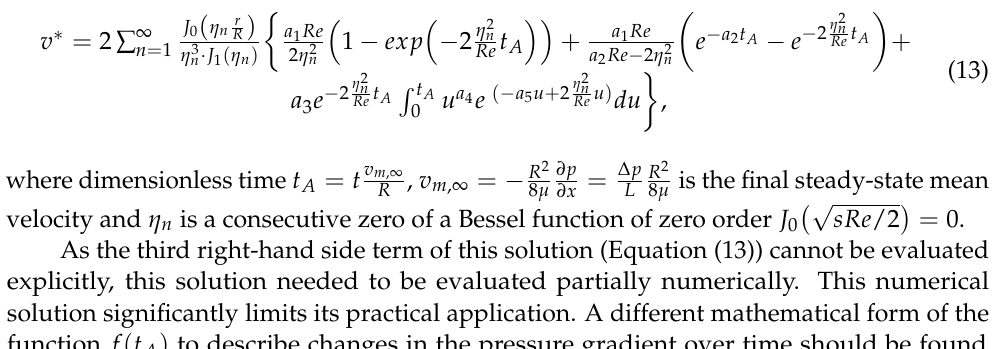
Figure 5. Exemplary variation of pressure gradient with time The final modified semi-analytical Avula’s solution for the velocity profile is: